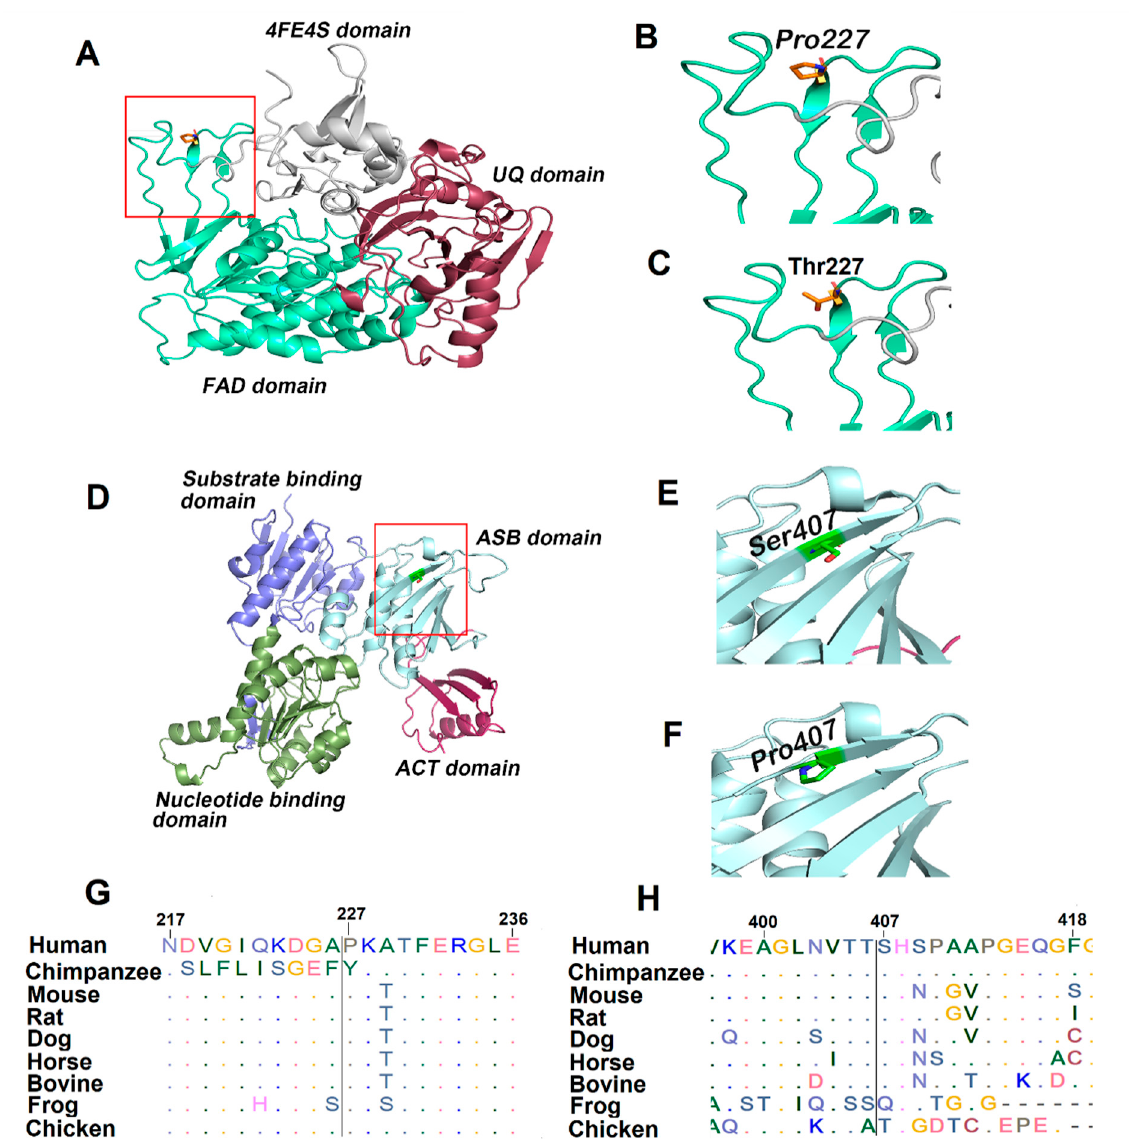
Figure 2. The generated homology models of ETFDH and PHGDH. The functional domains of ETFDH and PHGDH are demonstrated in cartoon representation, and the amino acid is represented with a stick representation. The boxed region shown red in A and D is enlarged in the successive images. ( A ) Modeled structure of ETFDH; ( B ) Wild type Pro227; ( C ) Mutant Thr227. ( D ) Modeled structure of PHGDH; ( E ) Wild type Ser407; ( F ) Mutant Pro407. Multiple sequence alignment of twenty amino acids centered on the missense mutation obtained from different mammals. ( G ) ETFDH, P227T (c. 679C>A); ( H ) PHGDH, S407P (c. 1219T>C).